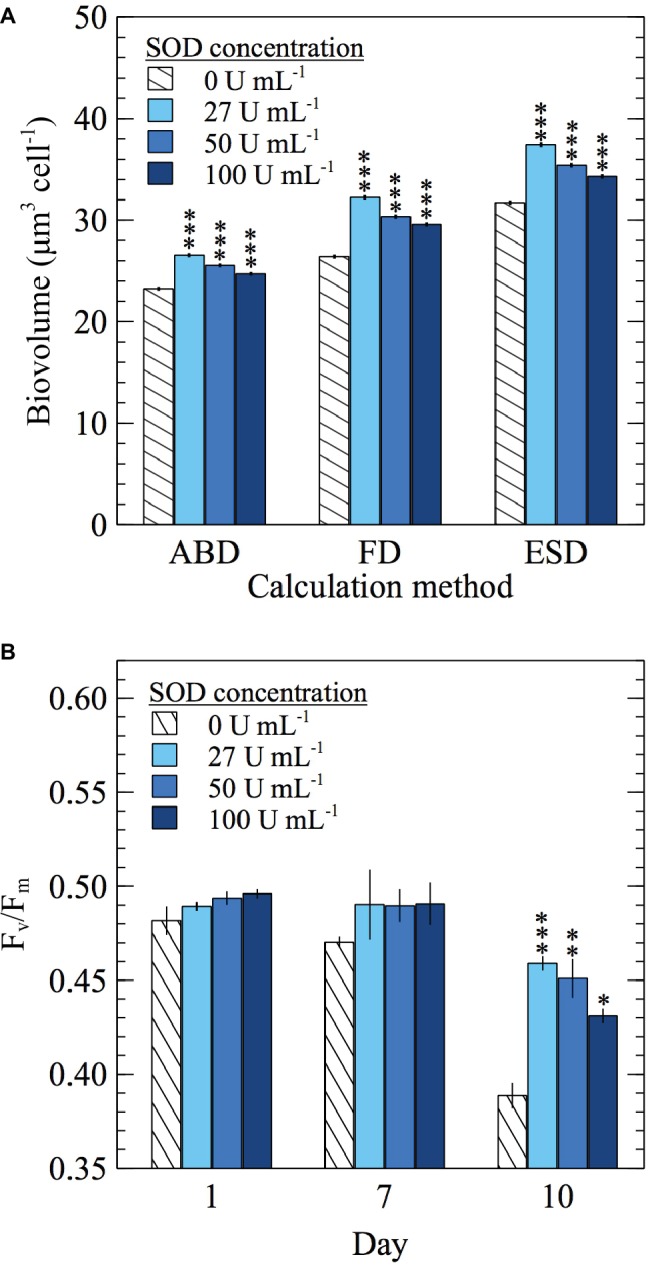
The effect of daily SOD additions on E. huxleyi
(A) cellular biovolume (n = 19,041, 17,344, 24,902, and 33,006 individual cells for 0, 27, 50, and 100 U ml−1 SOD, respectively) sampled on day 10 and calculated using three different measurements of cell diameter [area based diameter (ABD), filled or full diameter (FD), and equivalent spherical diameter (ESD)] and (B)
Fv/Fm values (n = 3 biological replicates). Significant differences (two sample Student’s t-test) relative to the control (0 U ml−1 SOD) are indicated by asterisks, where p < 0.05, < 0.01, and < 0.0001 are represented by *, **, and *** asterisk symbols, respectively. Error bars represent one standard error of the mean.